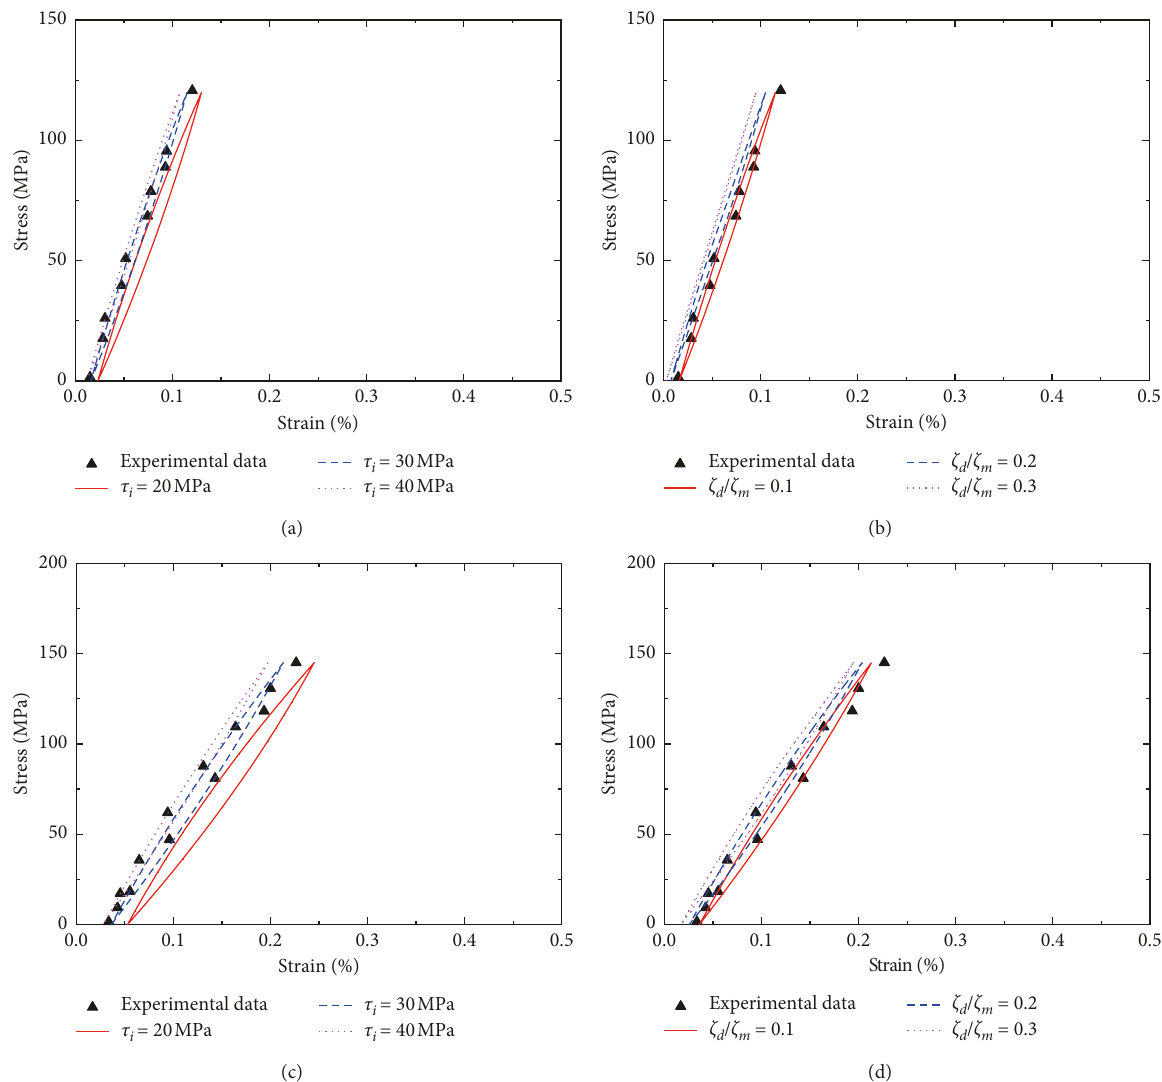
Figure 12: The experimental and predicted fatigue hysteresis loops of 2D Tyranno ™ SiC/SiC composite under (a) the fatigue peak stress of σ max � 120MPa for different interface shear stress; (b) the fatigue peak stress of σ max � 120MPa for different interface debonding energy; (c) the fatigue peak stress of σ max � 145MPa for different interface shear stress; (d) the fatigue peak stress of σ max � 145MPa for different interface debonding